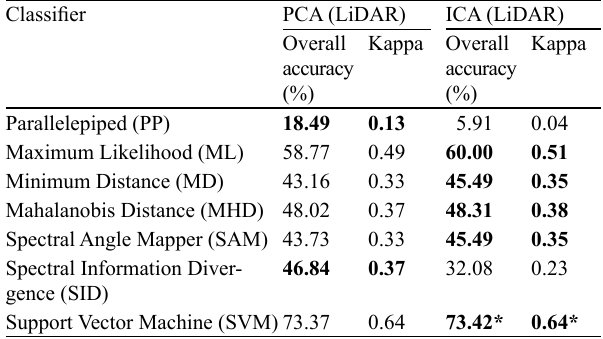
Table 2 Accuracy assessment for the classification of UAV-LiDAR